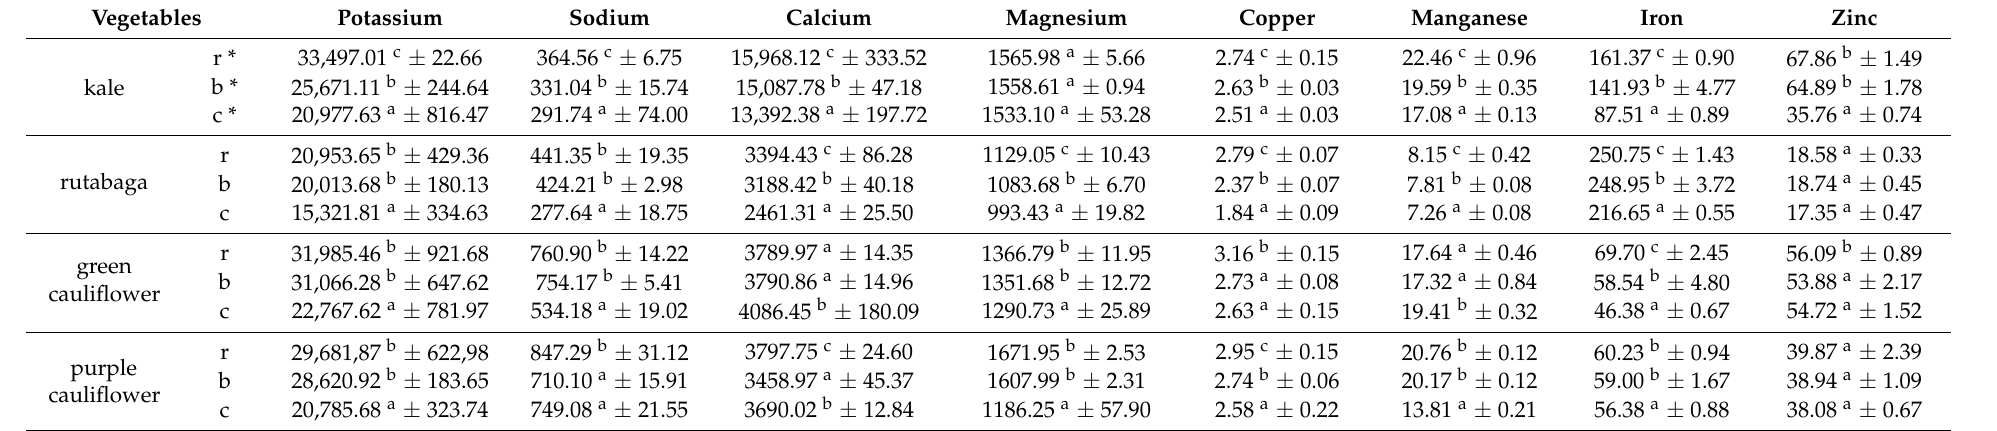
Table 1. The content (mean ± SD) of selected minerals in kale, rutabaga, green and purple cauliflower subjected to different technological processing (mg/kg dry matter). The values in the same columns denoted with different letters: a, b, c differ statistically significantly at p ≤ 0.05. * r-raw; b-blanched,